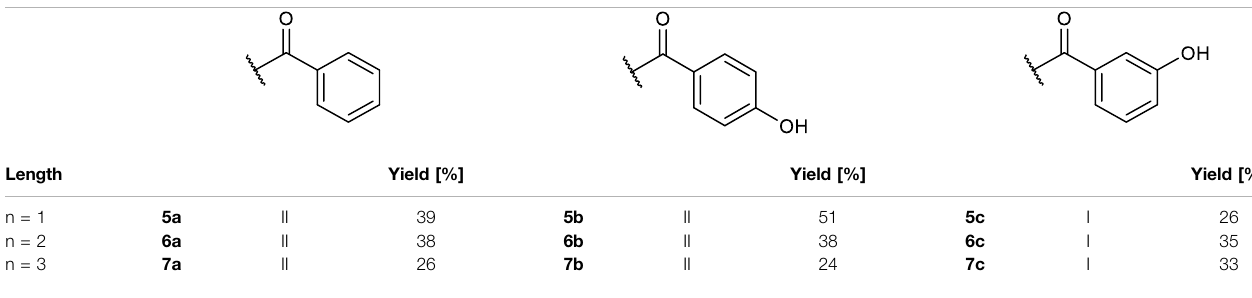
TABLE 2 | Yields and methods for the fi nal reaction step of Figure 4 where e) applies to I and f) to II.